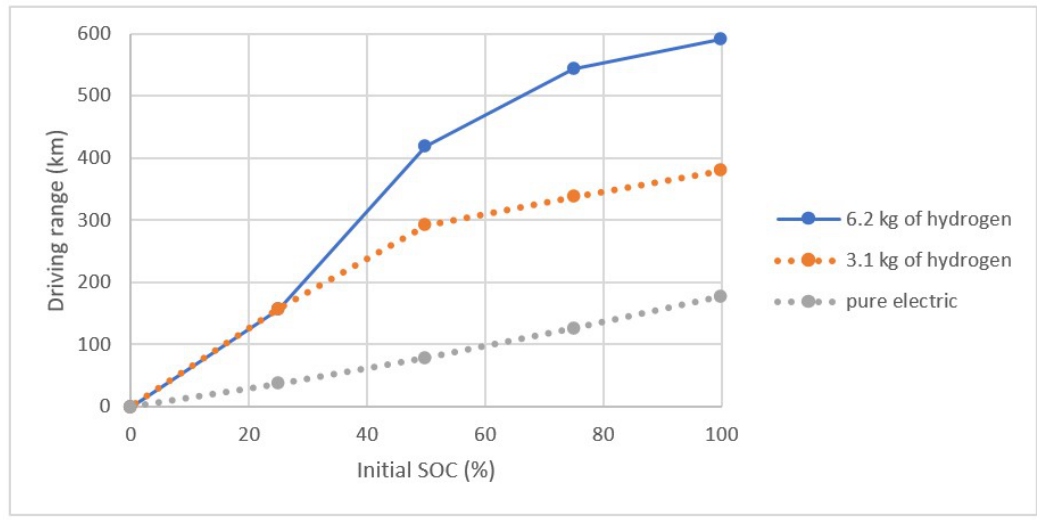
Figure 11. Calculated driving range for different initial SOCs and tank capacities.